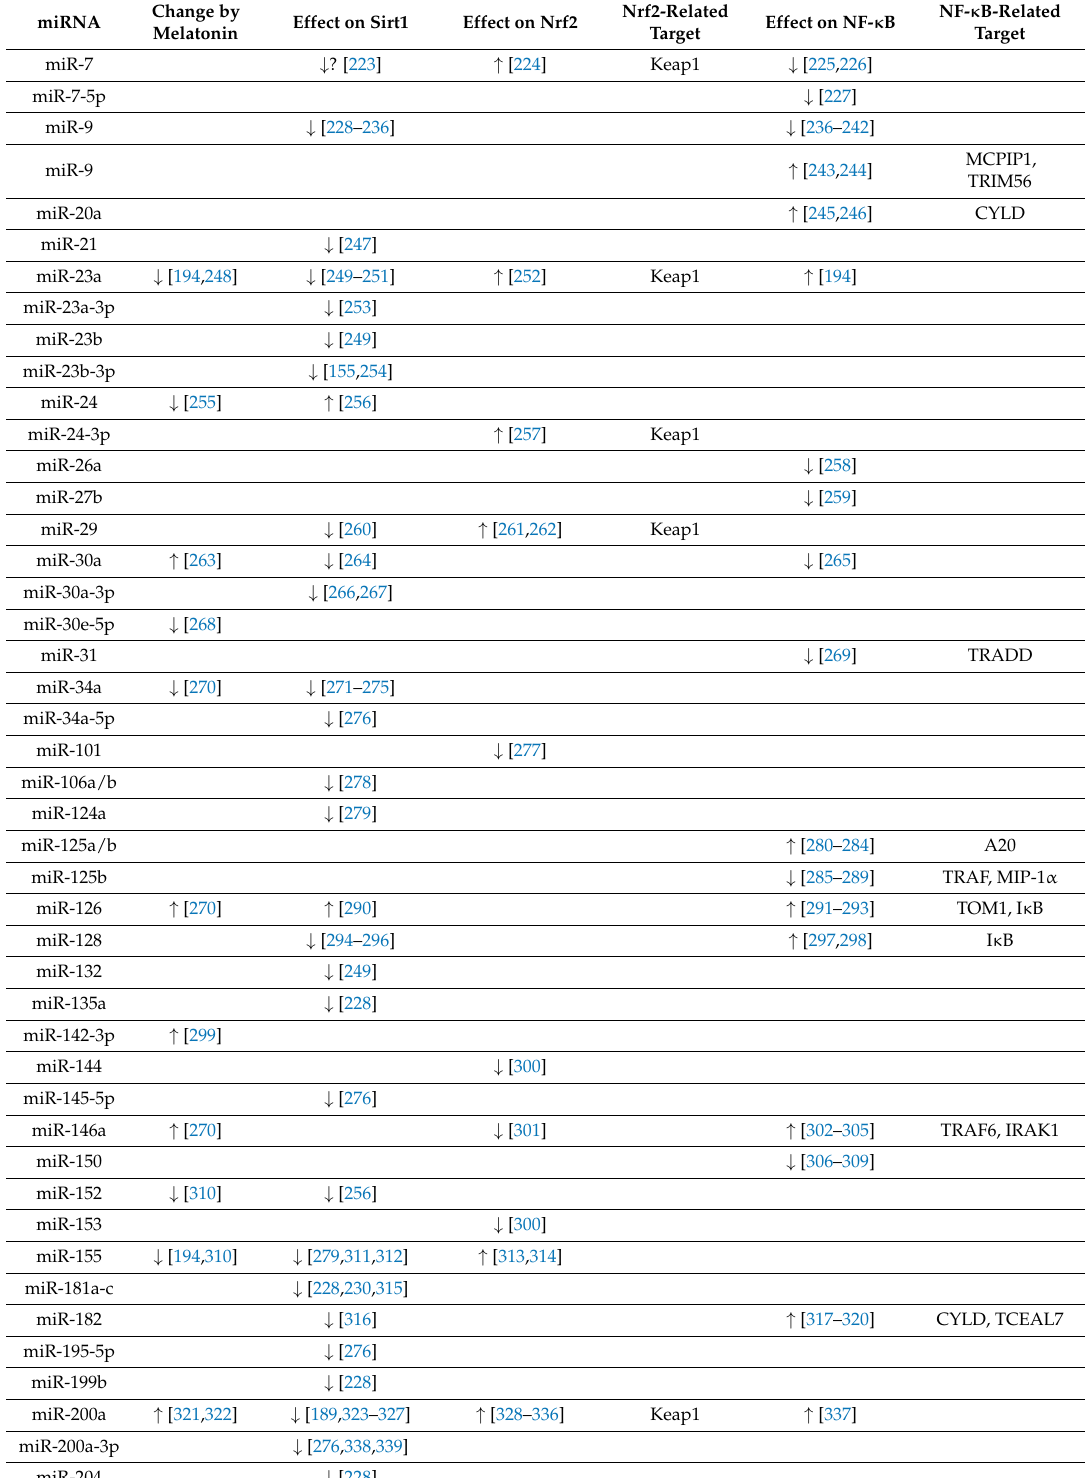
Table 1. Regulation of microRNA expression by melatonin and effects of microRNAs on SIRT1, Nrf2, and NF- κ B in the context of